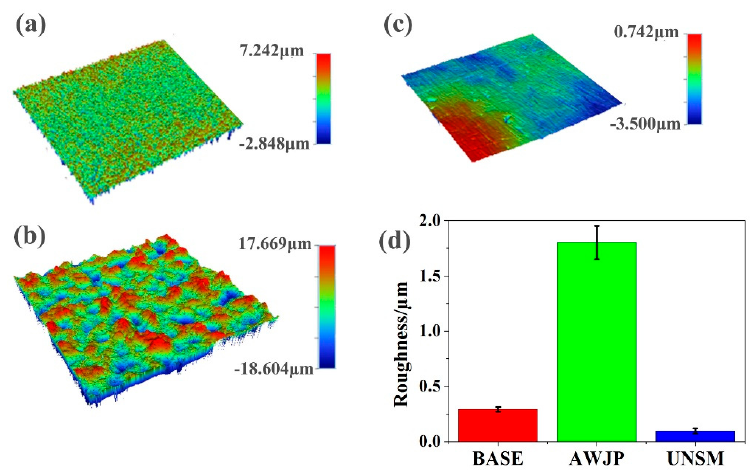
Figure 3. The 3D surface topographies of ( a ) Base, ( b ) AWJP, and ( c ) UNSM specimens, and ( d ) responding surface roughness, Ra, of the specimens .